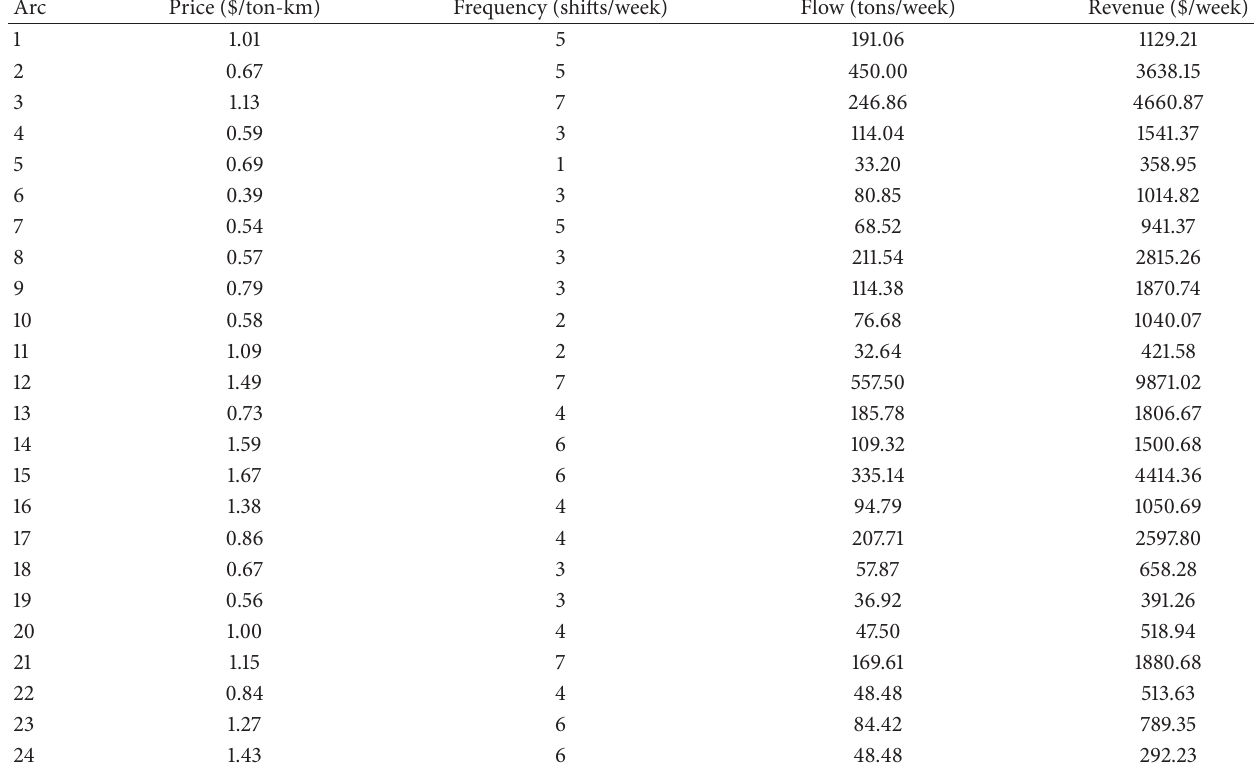
Table 5: Optimal decision for all operators on fare and frequency.